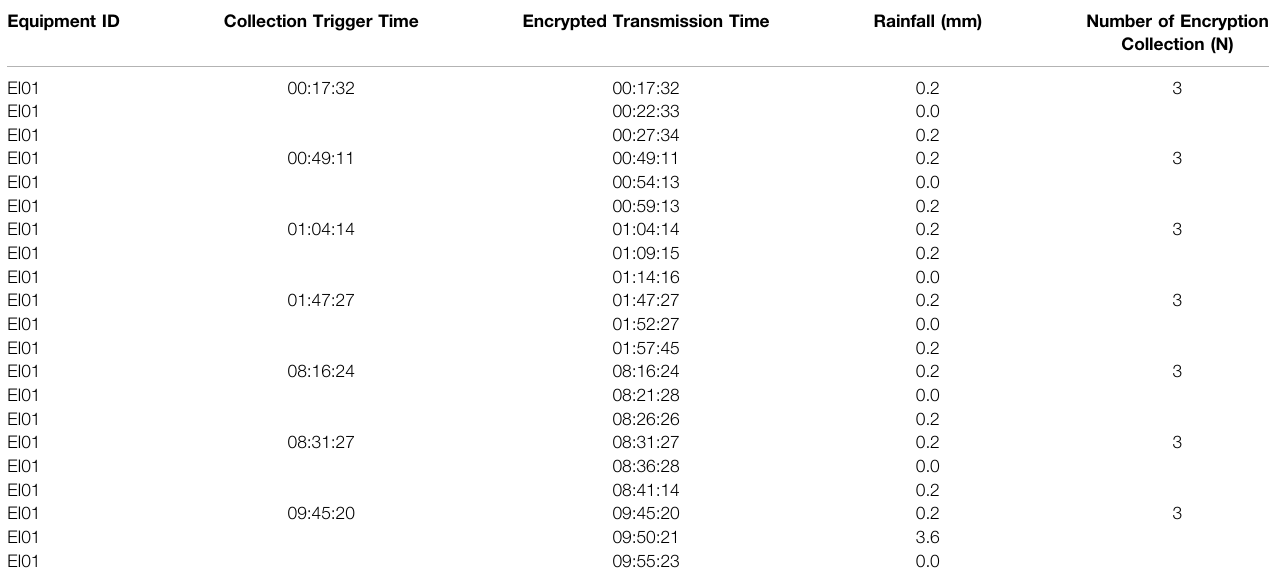
TABLE 3 | Adaptive encryption transmission data of landslide monitoring system. Equipment